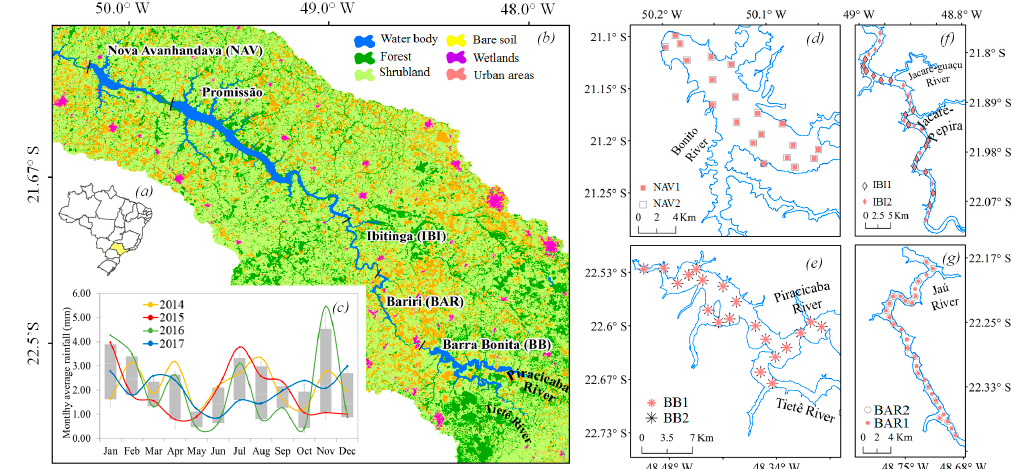
Figure 1. Brazil with S ã o Paulo State location ( a ); Map of five reservoirs in TCSR (note that Tr ê s Irm ã os is located after the Nova Avanhandava reservoir) and respective land cover classes of the Tiet ê Basin (water body, forest, shrubland, bare soil, wetlands, and urban areas by Coordenadoria de Planejamento Ambiental de S ã o Paulo, CPLA, 2010) ( b ). Monthly average rainfall data from NASA’s (National Aeronautics and Space Administration) Giovanni database for the period of 2014–2017 ( c ); and the sampling locations detailed for each reservoir: NAV1 (n = 20) and NAV2 (n = 20) ( d ); BB1 (n = 20) and BB2 (n = 30) ( e ); IBI1 (n = 10) and IBI2 (n = 20) ( f ); and BAR1 (n = 30) and BAR2 (n = 18) ( g ). All maps are in WGS84. NAV: Nova-Avanhandava, BB: Barra Bonita, IBI: Ibitinga, and BAR: Bariri.